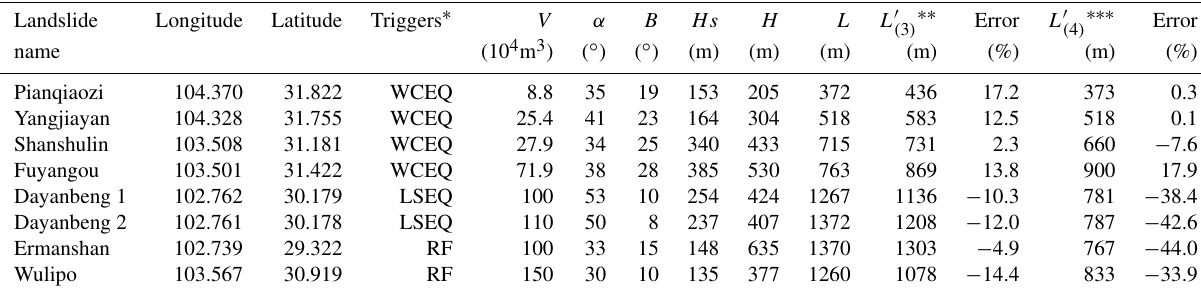
Table 5. Background parameters and predicted values of eight rock avalanches in the same area used for validation. Landslide